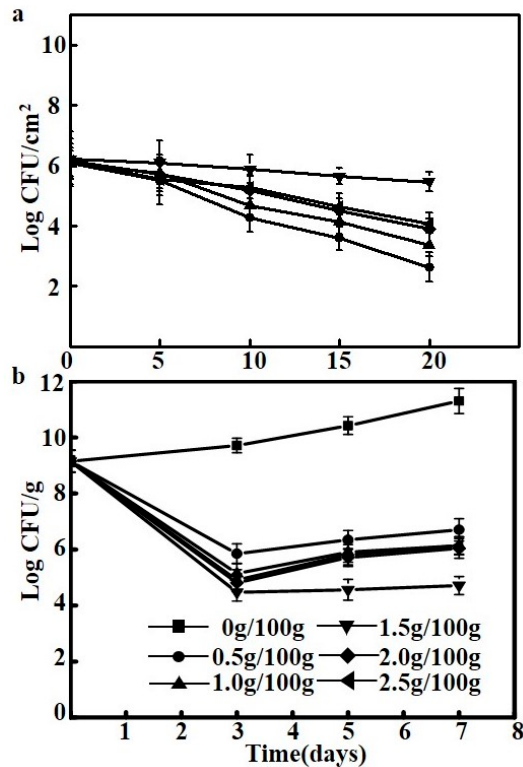
Figure 5. ( a ) The viability of Lactococcus lactis in different films for 20 day; ( b ) effect of bioactive films on the growth of Staphylococcus aureus on TSA medium stored at 4 °C.